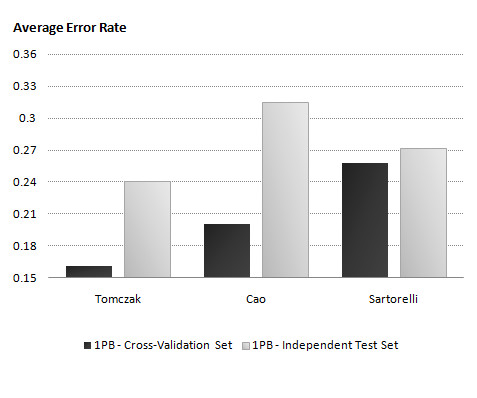
Evaluating the accuracy of 1PB using different datasets for gene selection. We selected genes using only one dataset (black) at a time and compared the average error rate of 1PB classifier learnt and trained on a same dataset and validated on the other two datasets independently (grey).